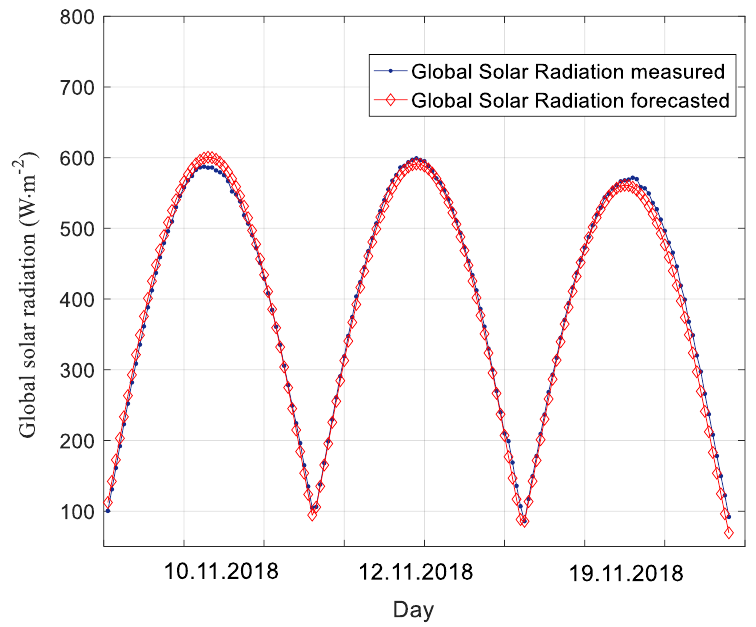
Figure 4. The forecast results of GHI under clear sky conditions (10.11.2018, 12.11.2018, 19.11.2018) for a total of 108 samples of the test set. Table 1. Statistical indexes for the clear sky model (in W / m 2 for RMSE, MAE, and MBE). RMSE nRMSE (%) MAE nMAE (%) MBE nMBE (%)